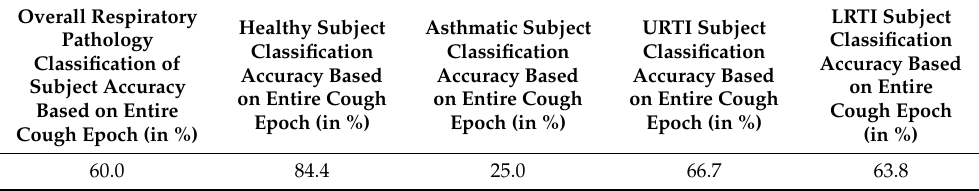
Table 8. Pathology classification accuracy for Healthy vs. Pathology 4-Class Model